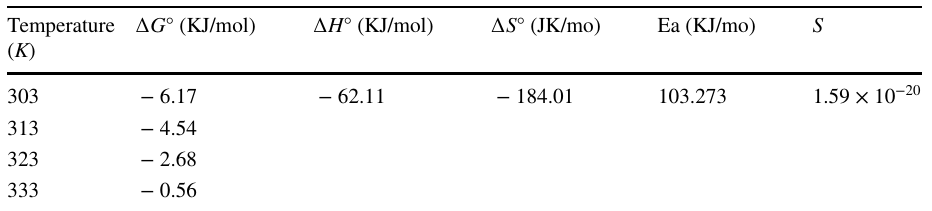
parameters of Rh-D adsorption on